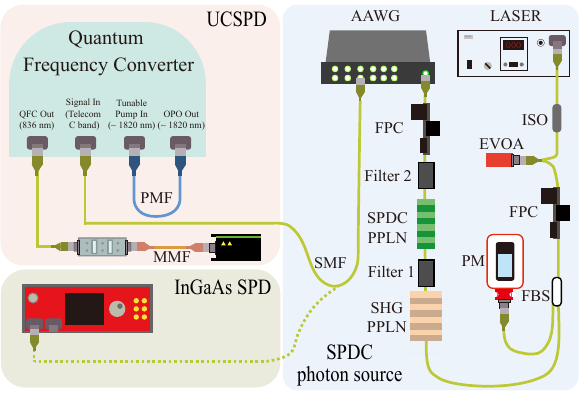
Figure 9: Schematic diagram of the optical setup for UCSPD performance test compared to the conventional InGaAs SPD using the heralded single-photon